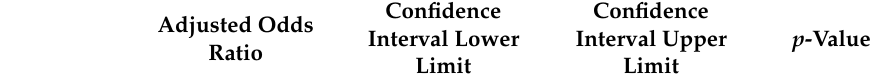
Table 3. Multivariable logistic regression establishes an association of cognitive dysfunction with digital screen